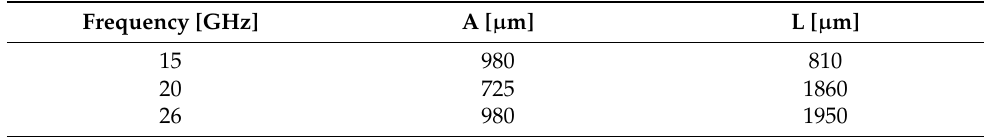
Figure 1. Design of ( a ) 26 GHz, ( b ) 20 GHz, and ( c ) 15 GHz resonators. Table 1. Sizes and geometrical details for the exploited U-shaped resonators.